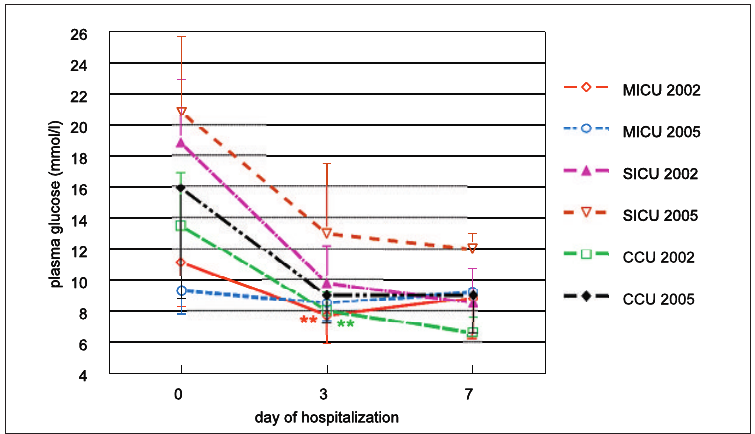
Plasma glucose in medical and surgical ICU patients and in the CCU during hospitalisation in 2002 and in